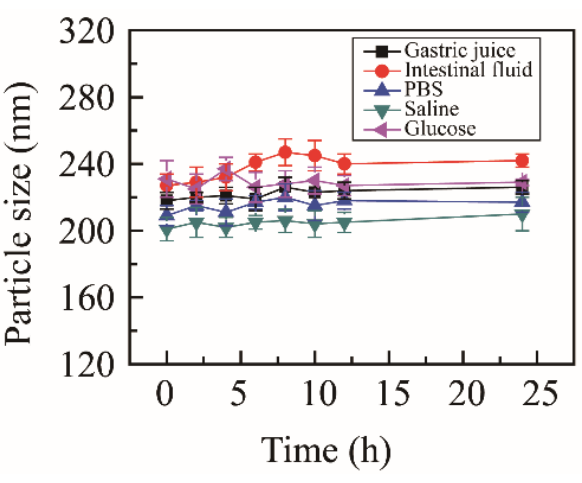
Figure 2. Particle size of NRG-NSps in different physiological media at 37 °C.